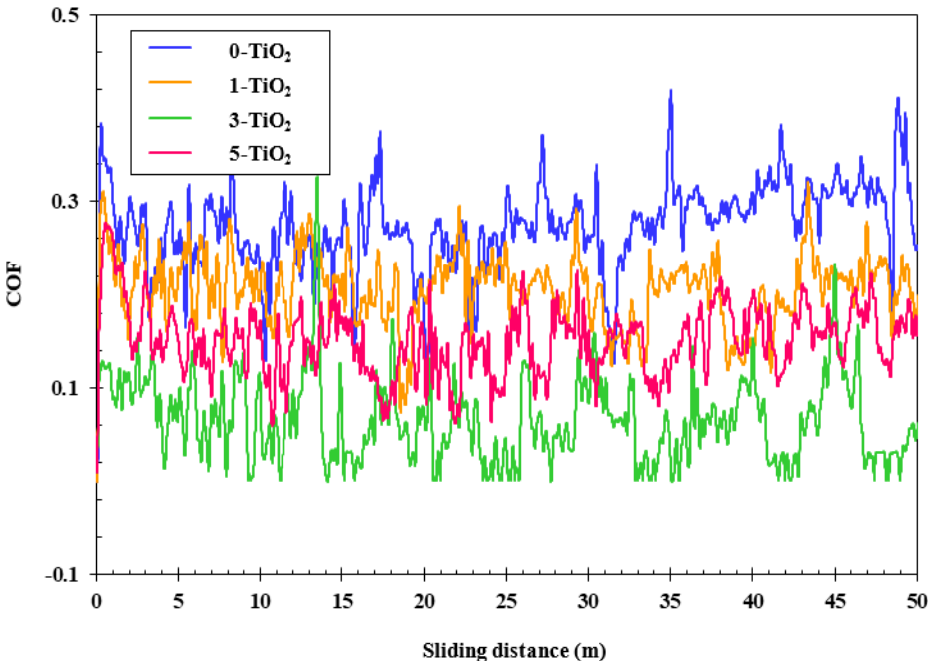
Figure 4. The variation of the COF versus the sliding distance curves of different PEO coatings recorded during the ball-on-disk wear test in the SBF solution.